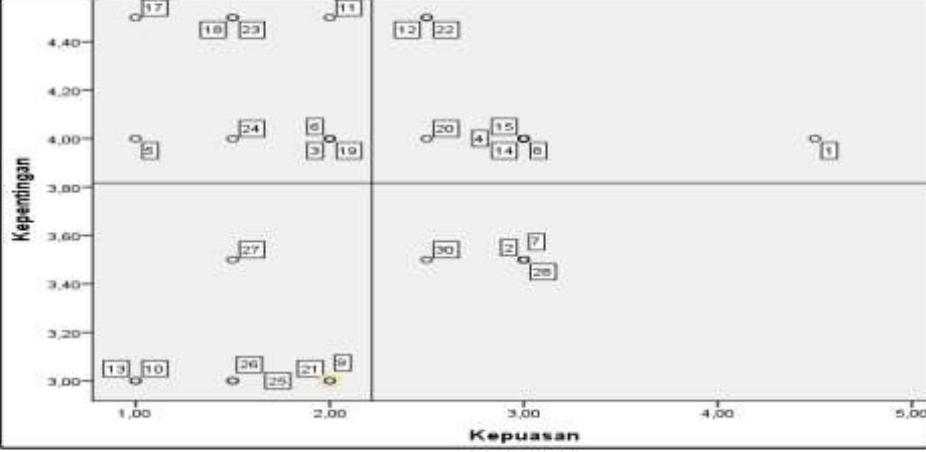
Figure 5. Importance Performance Analysis (IPA) Bangka Source: Processed, 2019